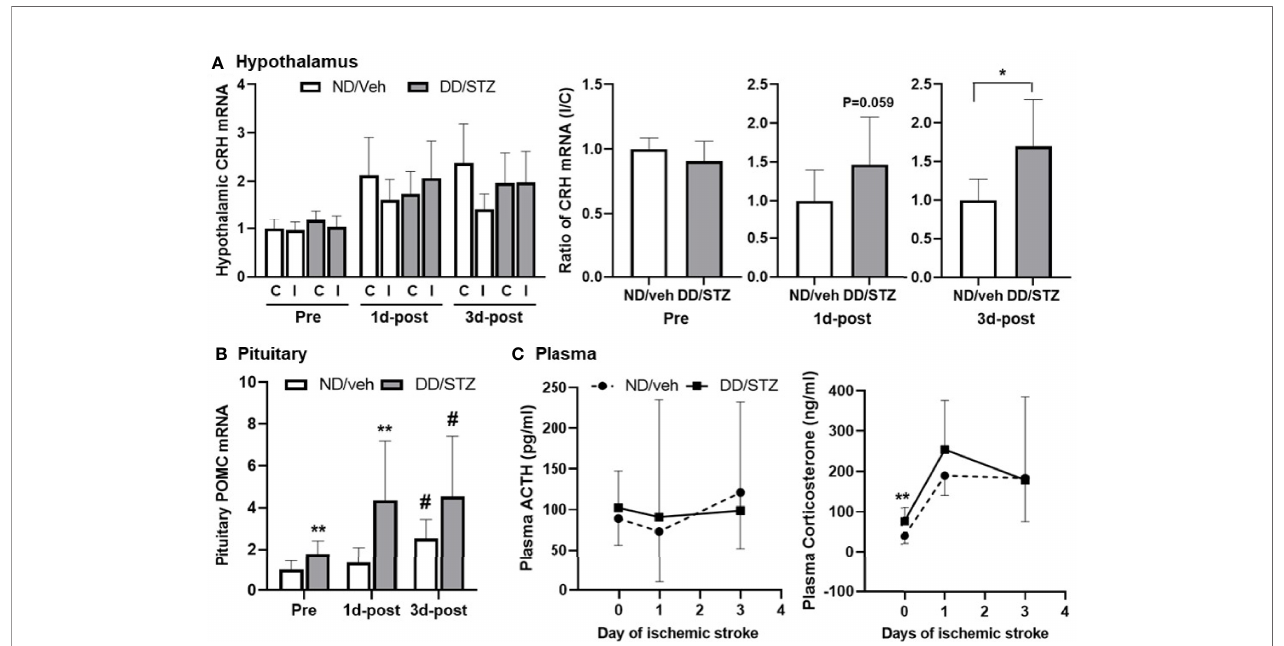
FIGURE 3 | Enhanced expression of HPA components and plasma glucocorticoids in diabetic mice before and after ischemic stroke. (A) Real-time PCR analysis of CRH mRNA levels in the hypothalamus. Each gene expression level was normalized by GAPDH. The mean value of contralateral of ND/veh (hypothalamus) at pre or ND/veh (for the ratio) was regarded as 1, and we calculated the relative values for the others. Data are presented as means ± SD. * p < 0.05 vs. ND/Veh, Student ’ s t -test. (B) POMC mRNA in the pituitary of ND/Veh and DD/STZ mice. Each gene expression level was normalized by GAPDH. The mean value of ND/veh at pre was regarded as 1, and we calculated the relative values for the others. Data are presented as means ± SD. * p < 0.05, ** p < 0.01 vs. ND/Veh. # p < 0.05 vs. Pre. Two-way ANOVA and Bonferroni test. (C) Plasma ACTH and corticosterone levels in the mice before (pre) and after stroke, 1 day (1d-post) or 3 days post-stroke (3d-post). n = 5 – 10/group (prior to stroke, 5 for ND/veh, 9 for DD/STZ; 1d-post, 10 for ND/veh, 10 for DD/STZ; 3d-post, 7 for ND/veh, 10 for DD/STZ). Each value is the mean ± SD. ** p < 0.01 vs. ND/Veh, Student ’ s t -test; ND/veh, mice fed normal chow and injected vehicle; DD/STZ, mice fed HFD and injected STZ; C, contralateral; I,